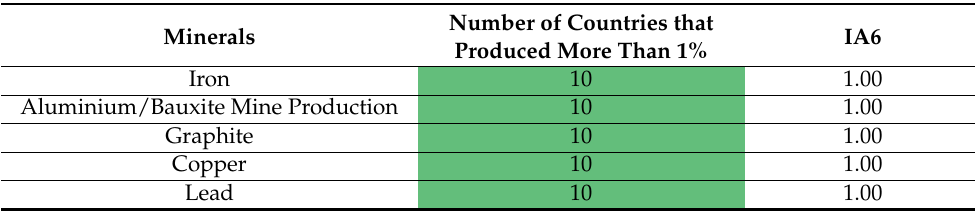
Table A6. Ranking of minerals by the number of countries that produced more than 1%